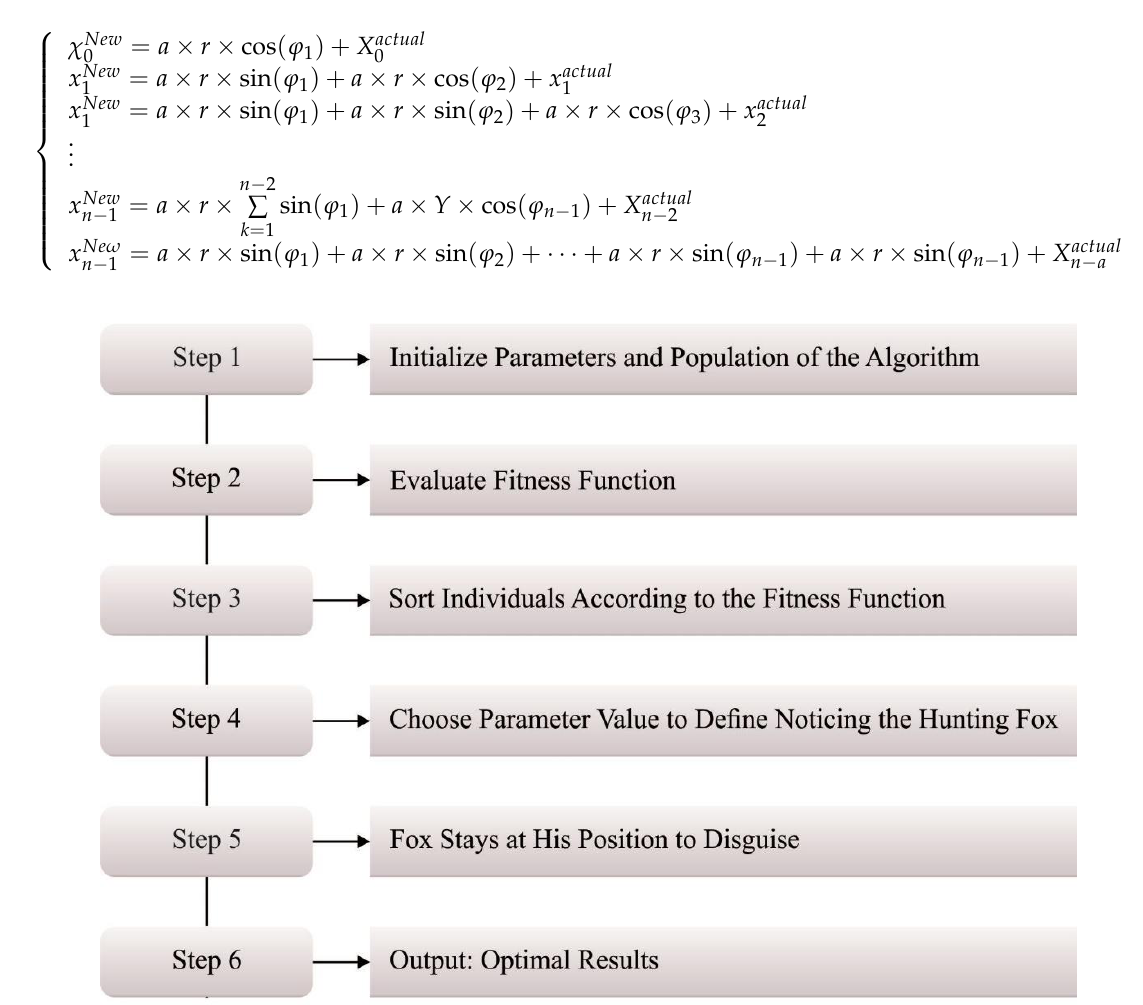
Figure 2. Steps involved in RFO technique.